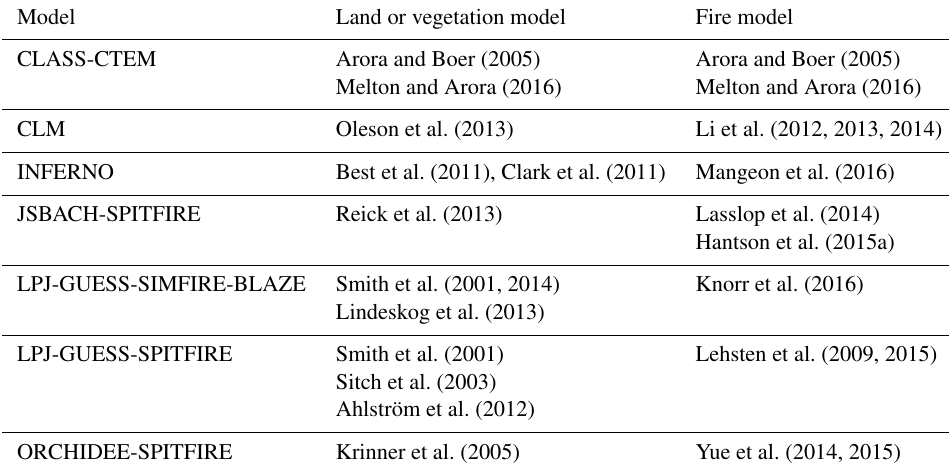
Table A1. Reference literature for FireMIP